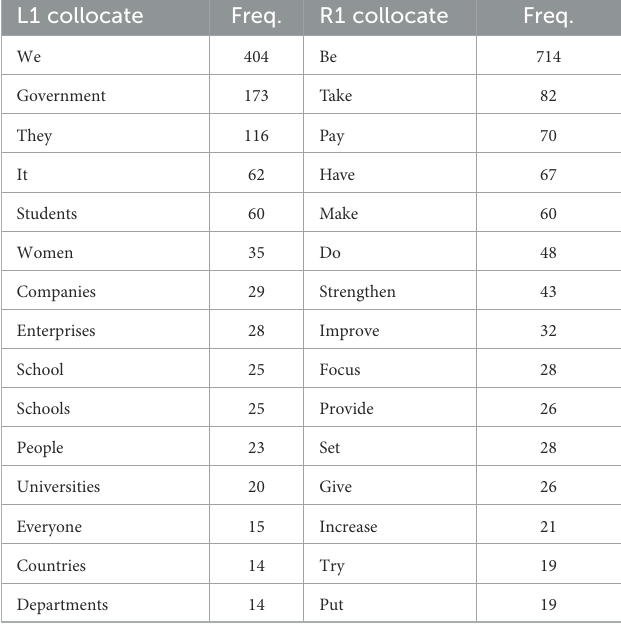
TABLE 4 Top 15 collocates of should within a span of one word to its left and one word to its right. L1 collocate Freq. R1 collocate Freq.